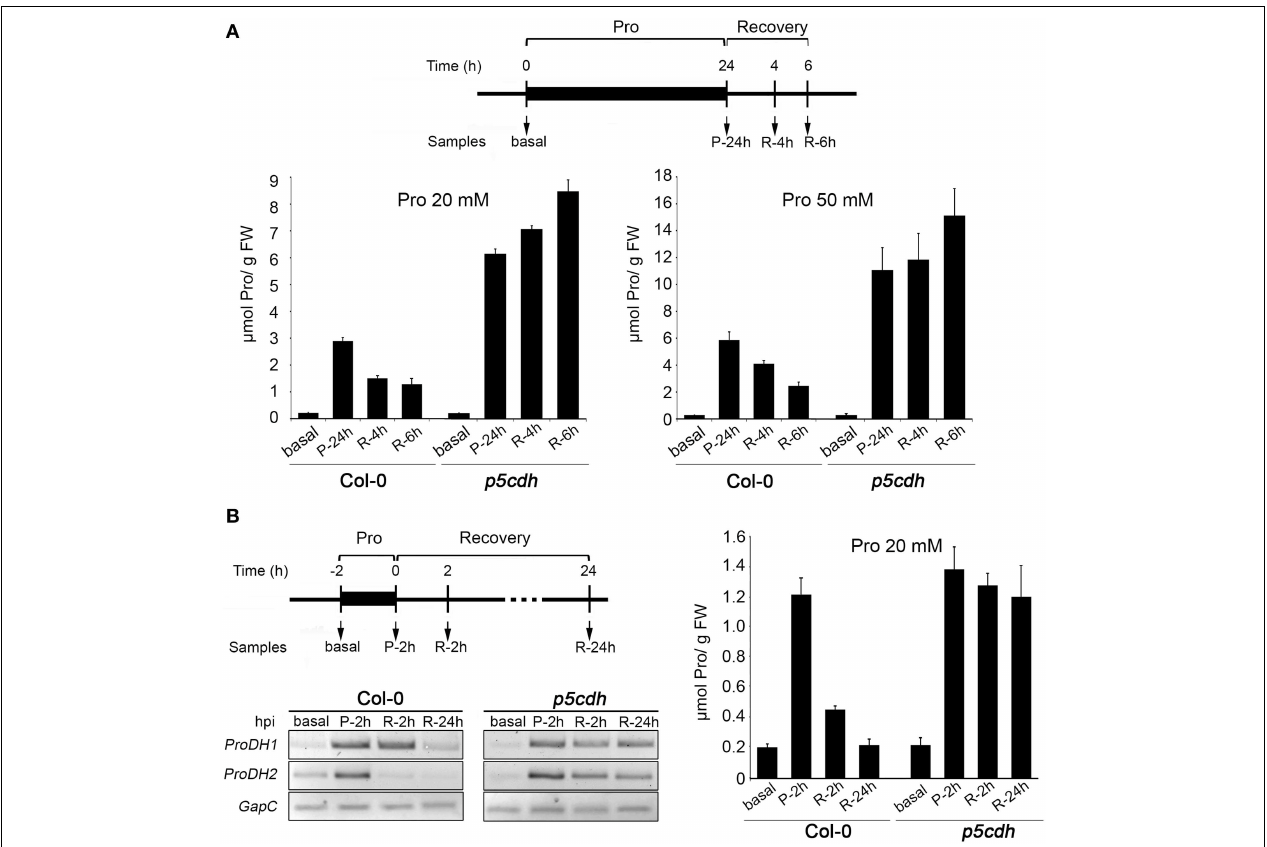
FIGURE 3 | Pro levels and ProDH expression in wild-type and p5cdh detached leaves treated with Pro. (A) Leaves were fed with 20 or 50mM Pro during 24h, and then deprived of the amino acid for 6h (recovery) to evaluate samples at different stages of treatment (top). Graphics compare the Pro levels in both genotypes (bottom). (B) Leaves fed with 20mM Pro for 2h, and deprived of the amino acid for 24h, were used to determine Pro levels and ProDH expression at different